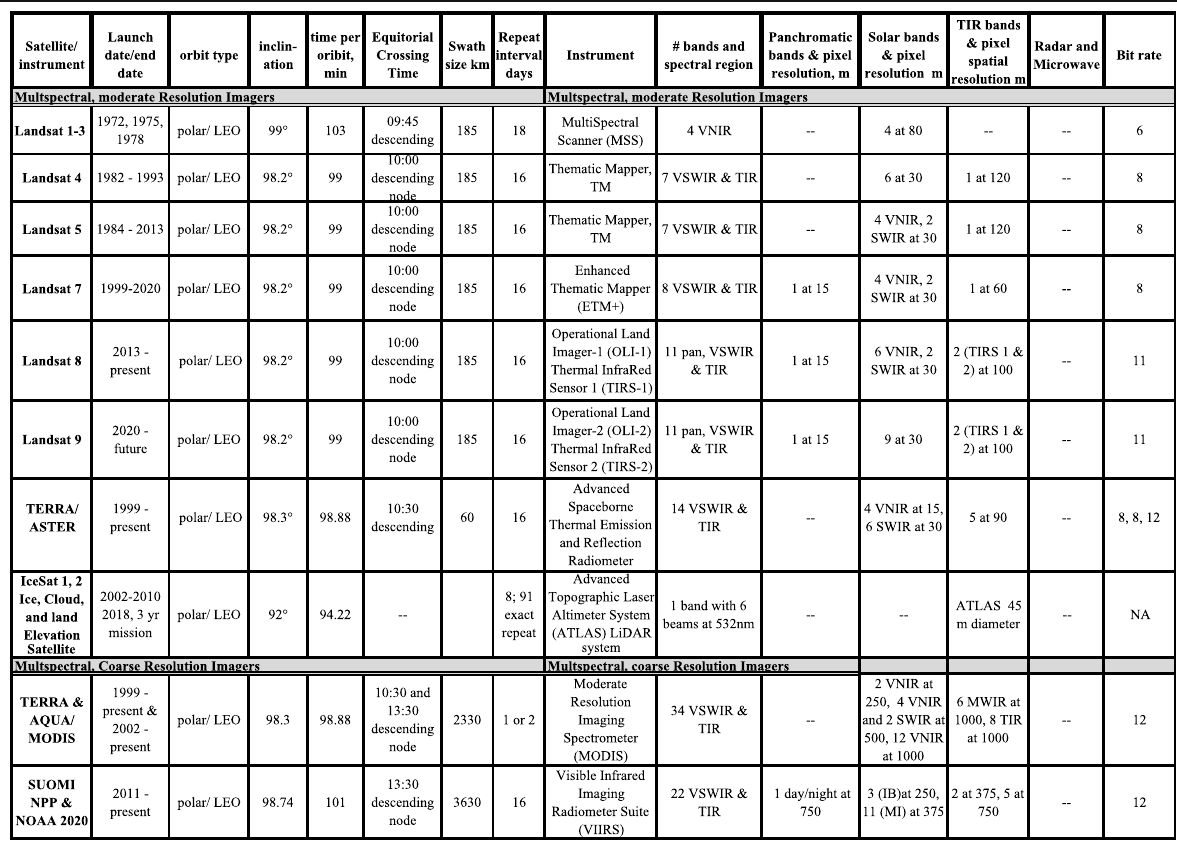
Table 2 Multispectral satellites of moderate spatial